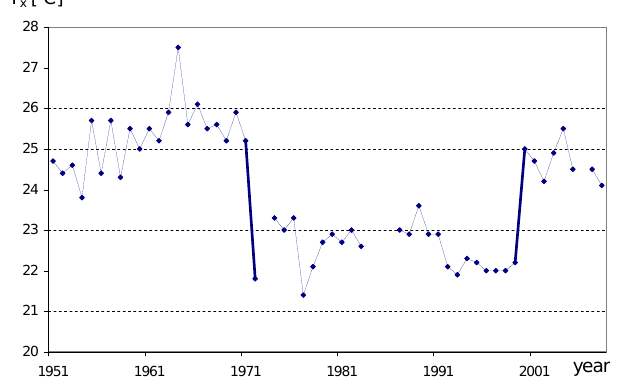
Figure 1. Summer daily maximum temperatures ( T x ) of Tarifa (Spain) between 1951–2008. The two spectacularly large shifts are marked with thick